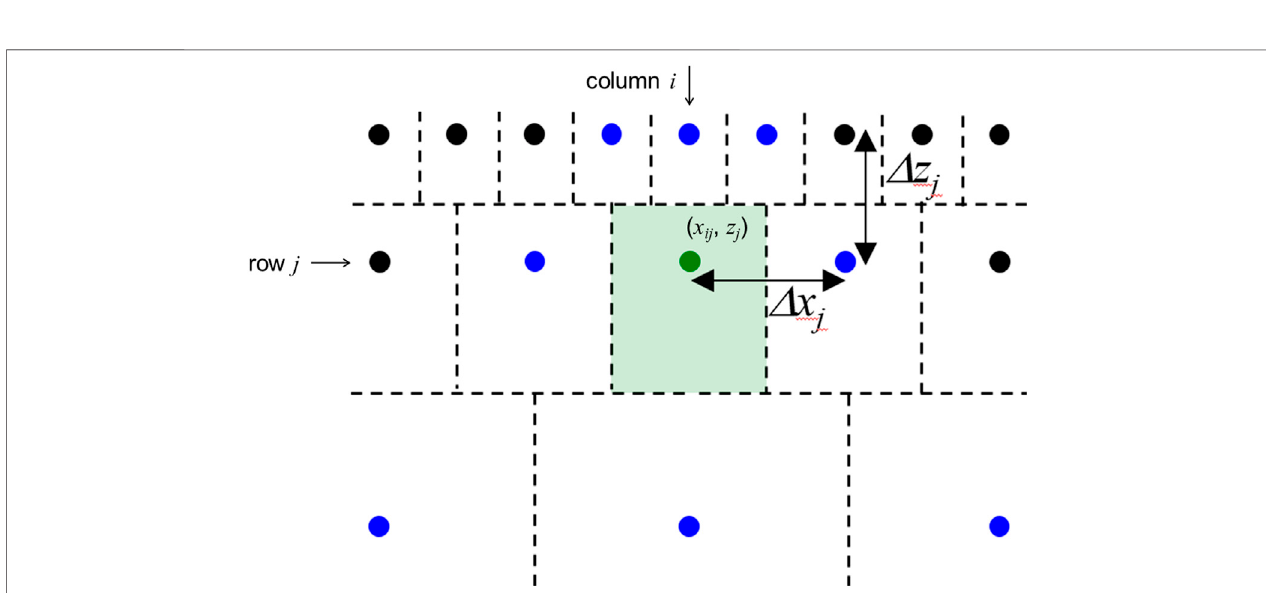
FIGURE 2 | Grid structure base on a binary hierarchy. Broken lines show the control volume associate with each node.